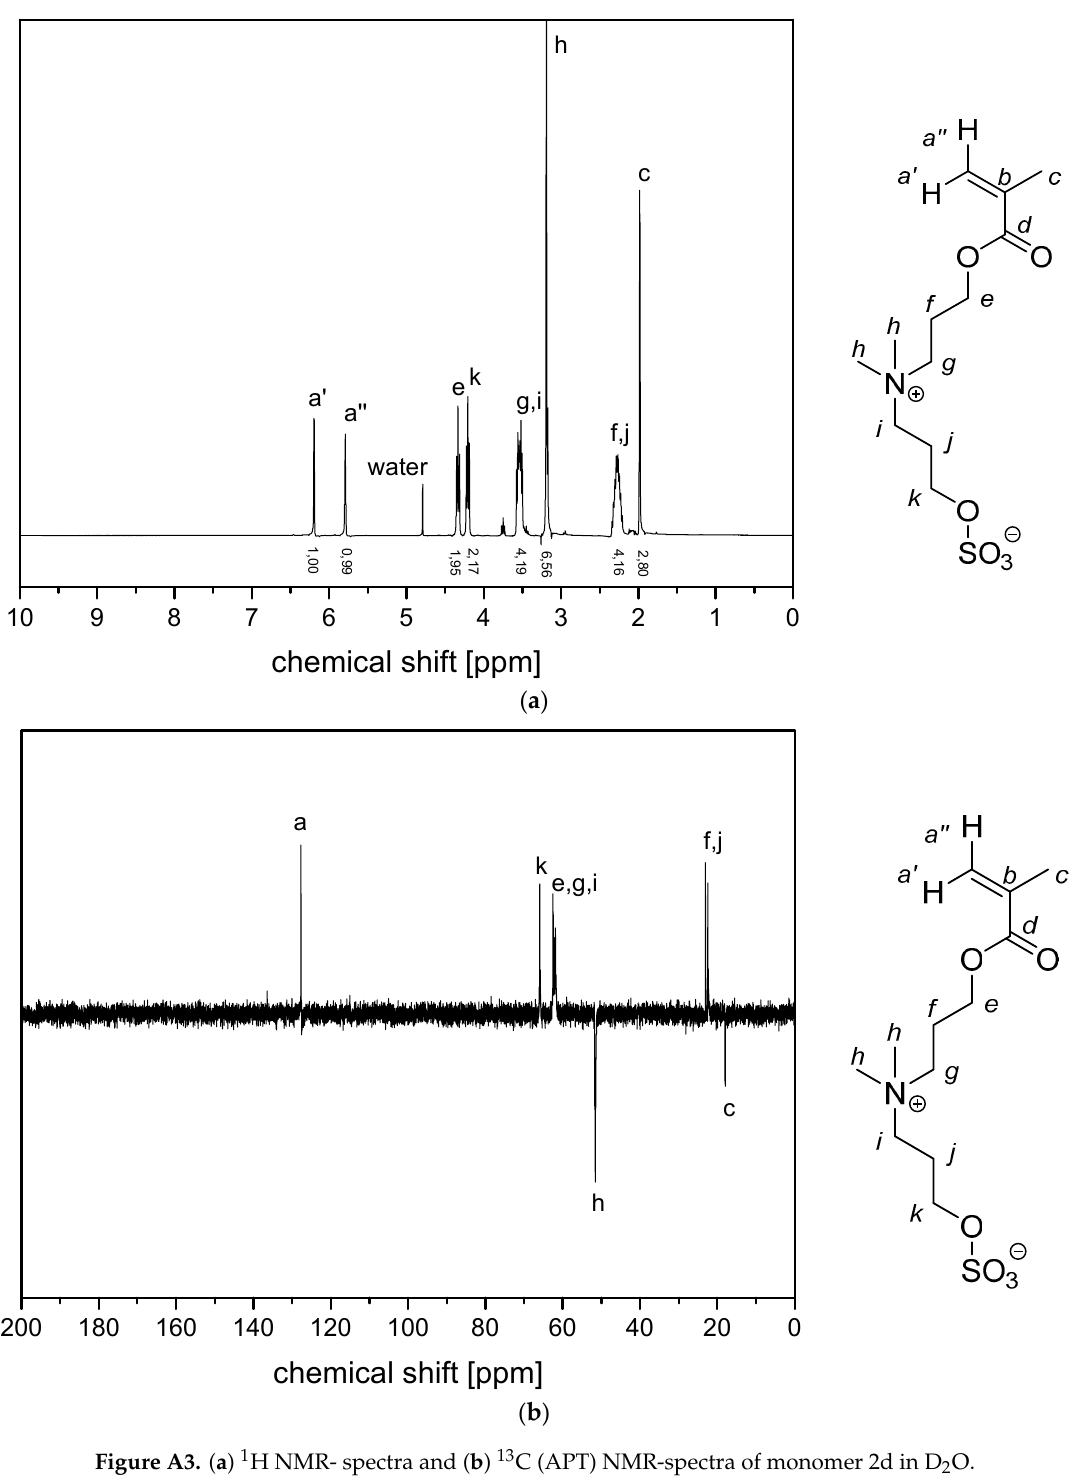
Figure A3 . ( a ) 1 H NMR- spectra and ( b ) 13 C (APT) NMR-spectra of monomer 2d in D 2 O. Figure A3. ( a ) 1 H NMR- spectra and ( b ) 13 C (APT) NMR-spectra of monomer 2d in D 2